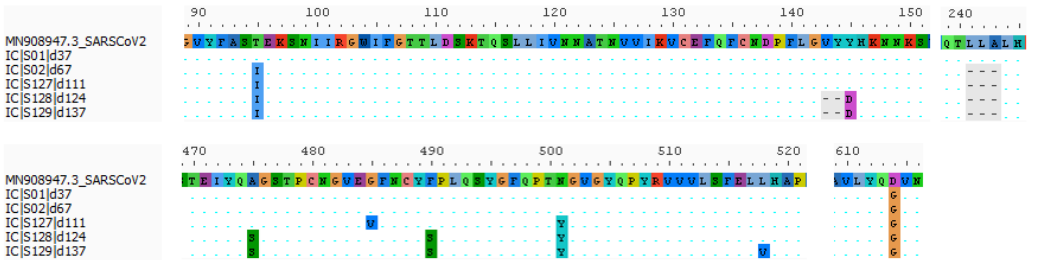
Figure 2. Amino acid changes in the S-gene of the patient’s SARS-CoV-2 genomes relative to the reference genome Wuhan-Hu-1. Deletions are marked in grey.